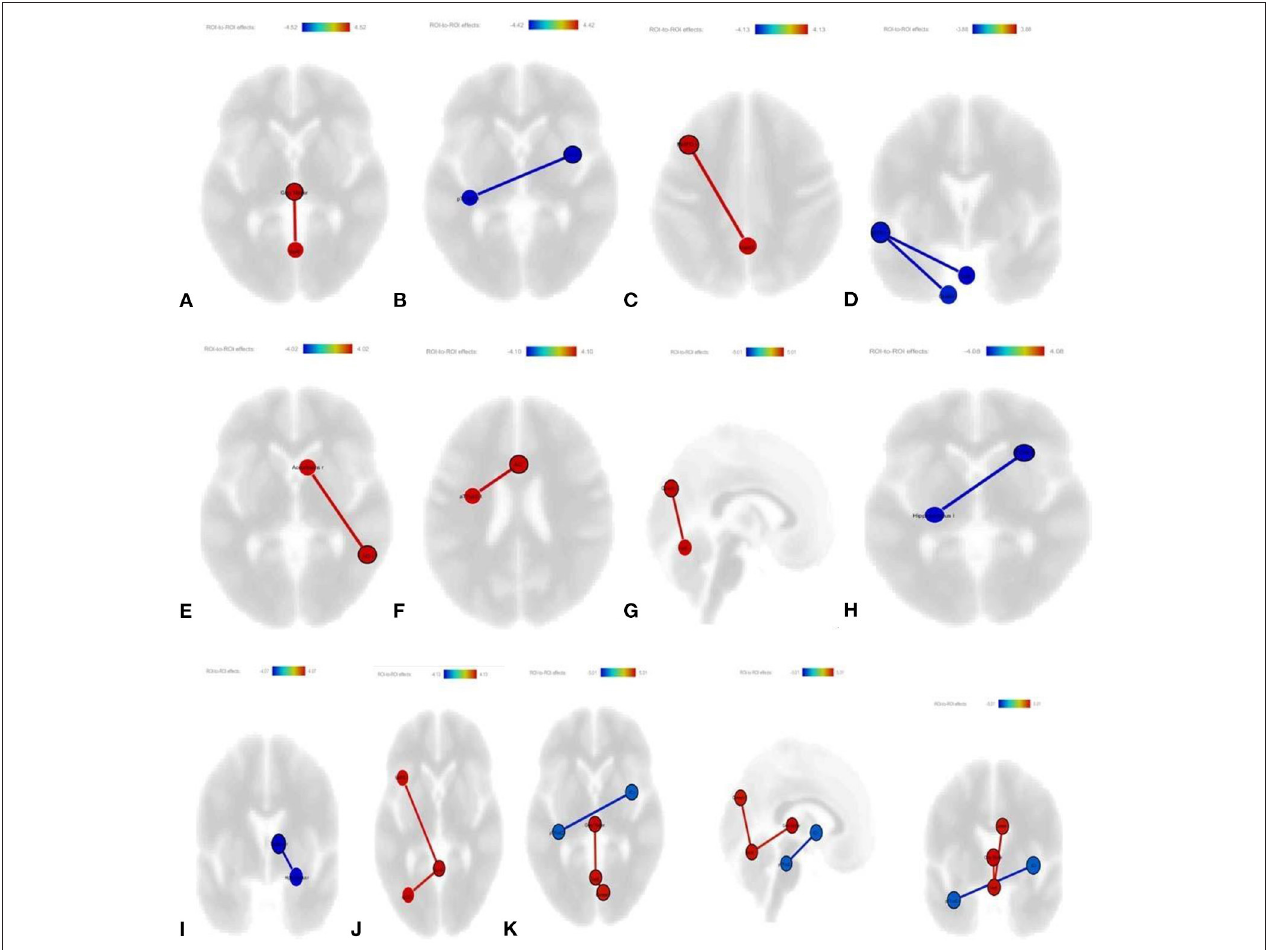
FIGURE 2 | (A) Increased connectivity between deep gray matter and vermis 6 ( p- unc: 0.0001; p- FDR: 0.0138); (B) decreased connectivity between right IC and left p TFus C ( p- unc: 0.0002; p- FDR: 0.0177); (C) increased connectivity between vermis 4–5 and left MFG; (D) decreased connectivity between left anterior STG with vermis 8 ( p- unc: 0.0004; p- FDR: 0.0333) and left cerebellum 9 ( p- unc: 0.0004; p- FDR: 0.0333); (E) increased connectivity between right AG and right Nacc ( p- unc: 0.0003; p -FDR: 0.0474); (F) increased connectivity between left anterior TFus C with ACC ( p- unc: 0.0002; p- FDR: 0.0388); (G) increased connectivity between the cuneal right and vermis 6 ( p- unc: 0.001; p- FDR: 0.042), (H) decreased connectivity between the right frontal orbital cortex and the left hippocampus ( p- unc: 0.0002; p- FDR: 0.0404); (I) decreased connectivity between the right thalamus and the right hippocampus ( p- unc: 0.0003; p- FDR: 0.0415); (J) increased connectivity between vermis 4–5 with left MFG ( p- unc: 0.0002; p- FDR: 0.0346) and left superior LOC) ( p- unc: 0.0004; p- FDR: 0.0346); (K) all ROI’s are shown together as a picture.